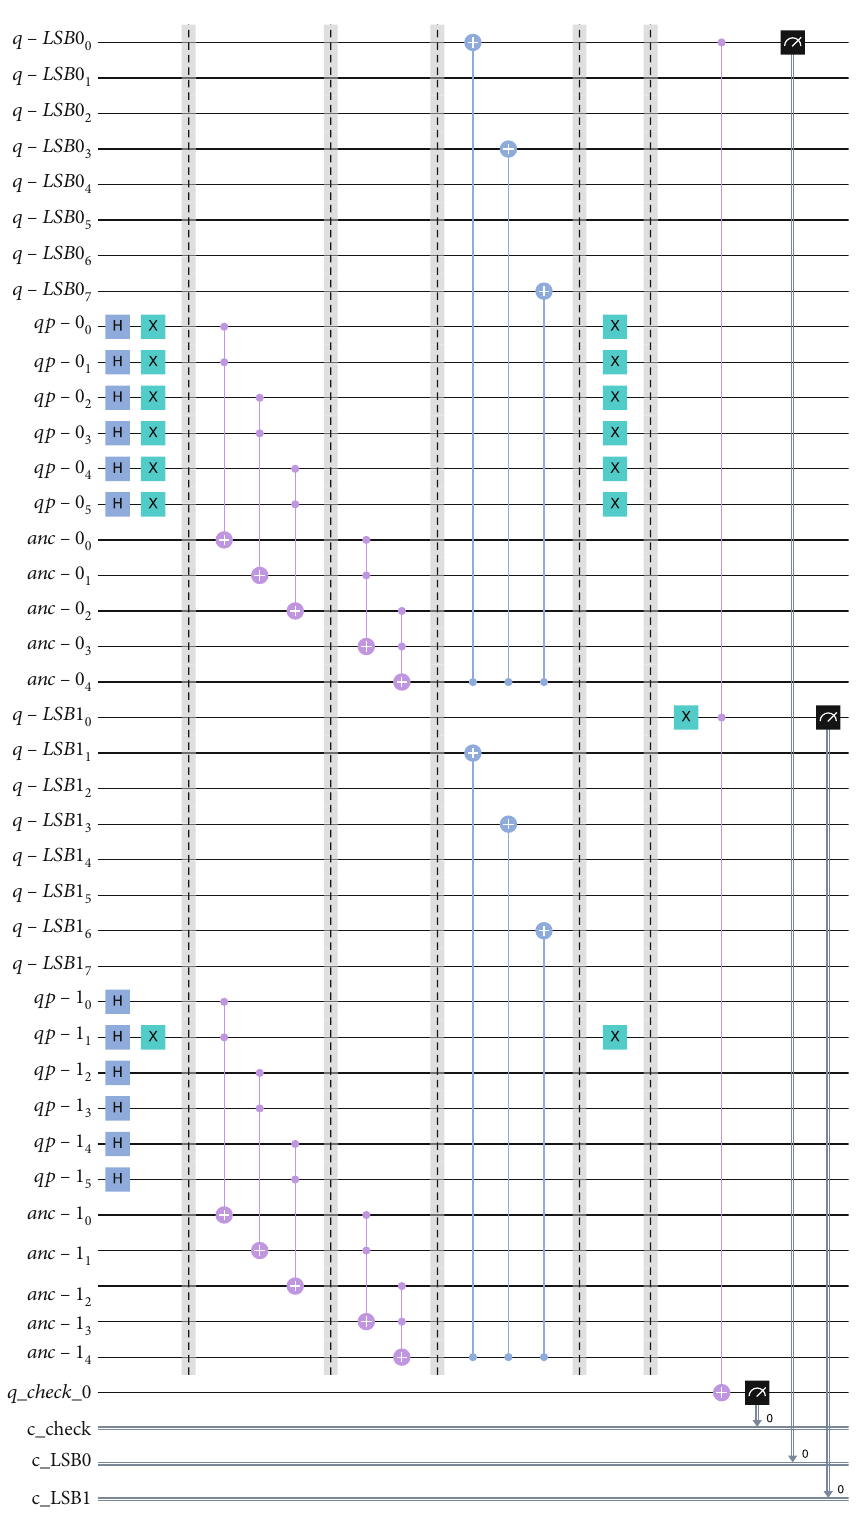
and q -LSB1 ). In this 0 0 . The representation for each gray value is explained in detail in Figures 5 0